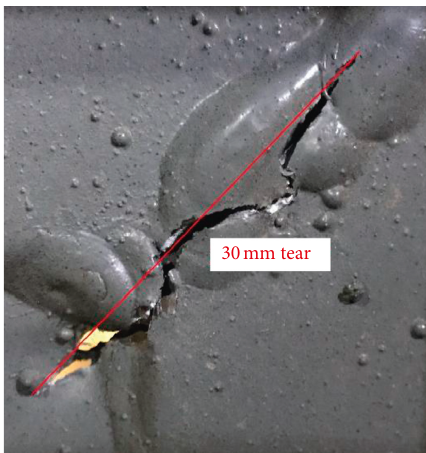
Figure 3: Tear at the interface between fish and infill steel plates at the end of 12mm cyclic